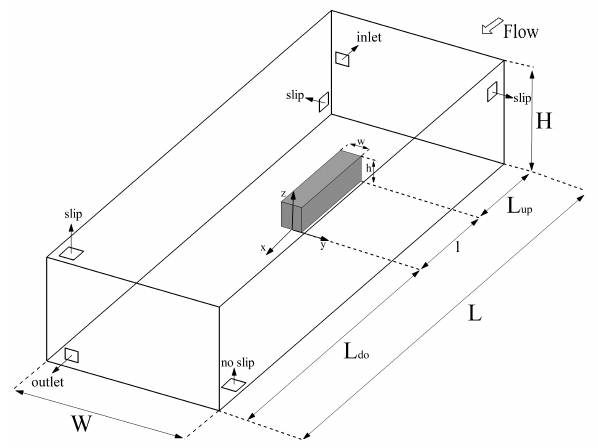
Figure 3. Schematic of the computational domain (not to